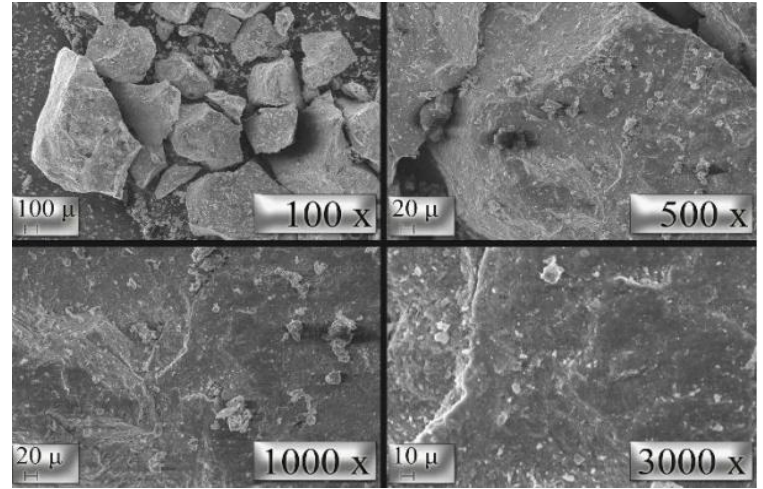
Figure 5. SEM micrograph of ASC at a magnification of 100 to 3000 ×.